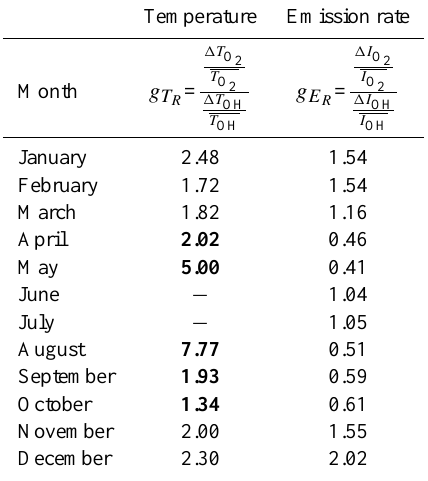
Table 5. Amplitude growth factor. Values obtained from tempera- ture amplitudes smaller than 3K in